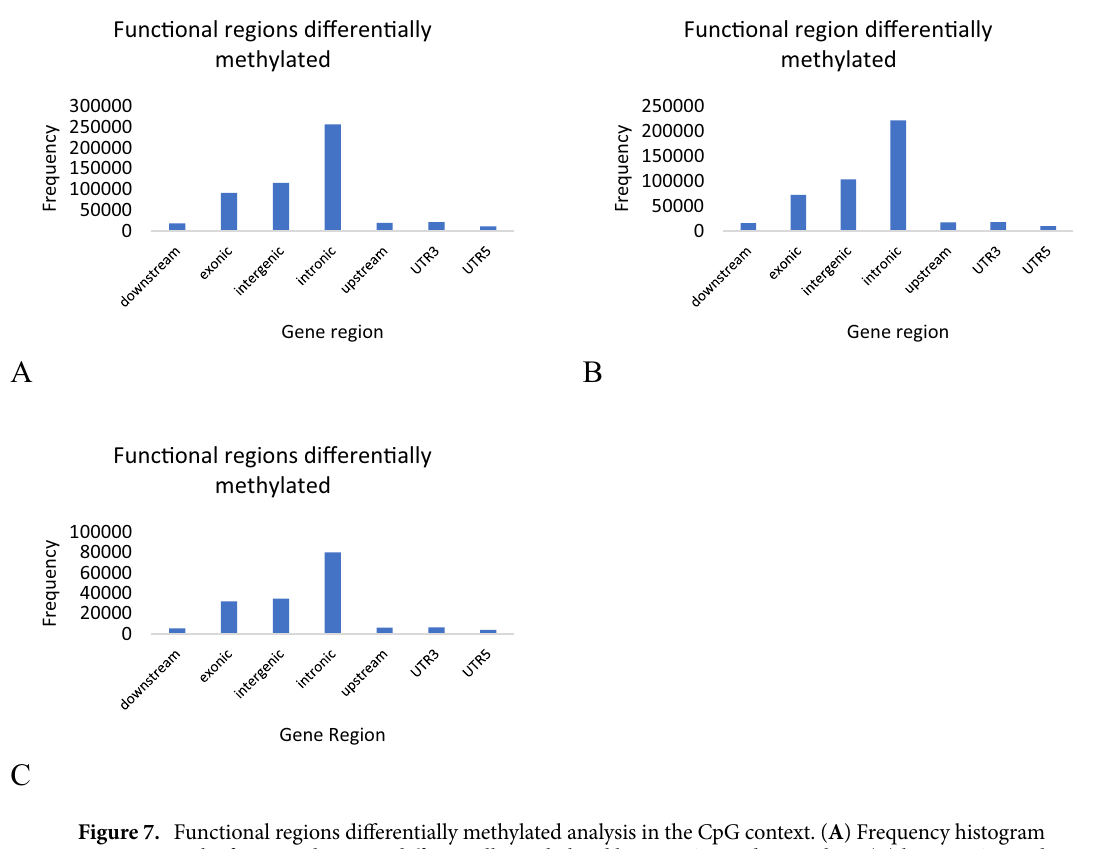
Figure 7. Functional regions differentially methylated analysis in the CpG context. ( A ) Frequency histogram representing the functional regions differentially methylated between ZE and normal SE, ( B ) between ZE and abnormal SE and ( C ) between normal and abnormal SE where intronic, intergenic and exonic regions have the highest